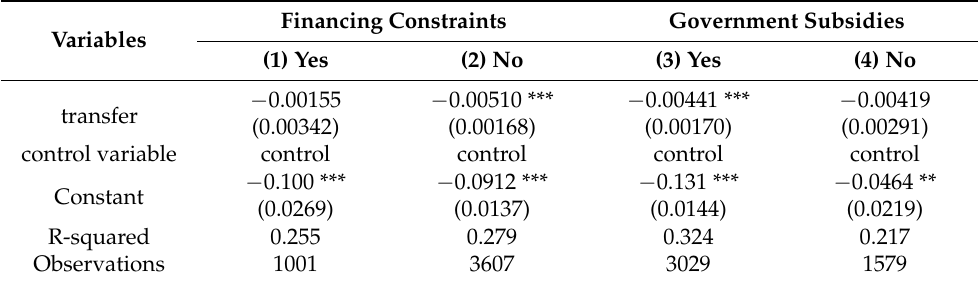
Table 4. Regression results grouped by financing constraints and government